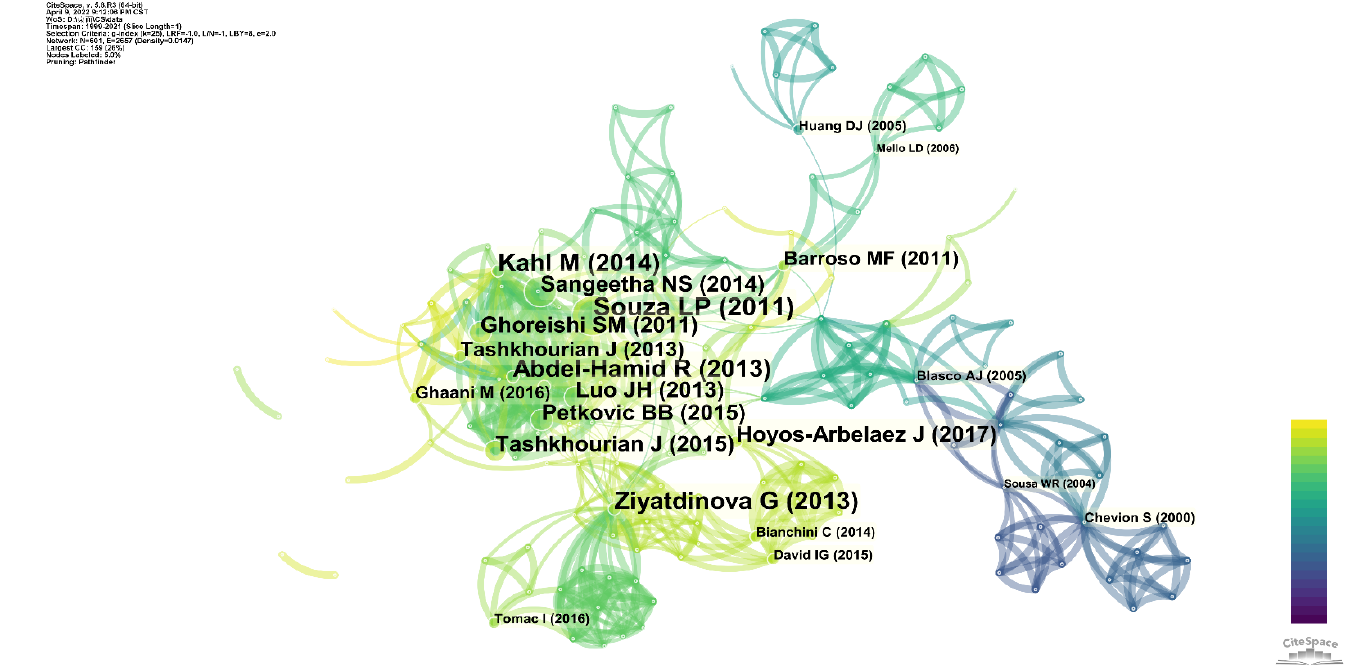
Figure 10. Co-citation analysis for the evaluation of antioxidants using electrochemical sensors. There are smaller sub-networks at the top and bottom right of the figure, and these